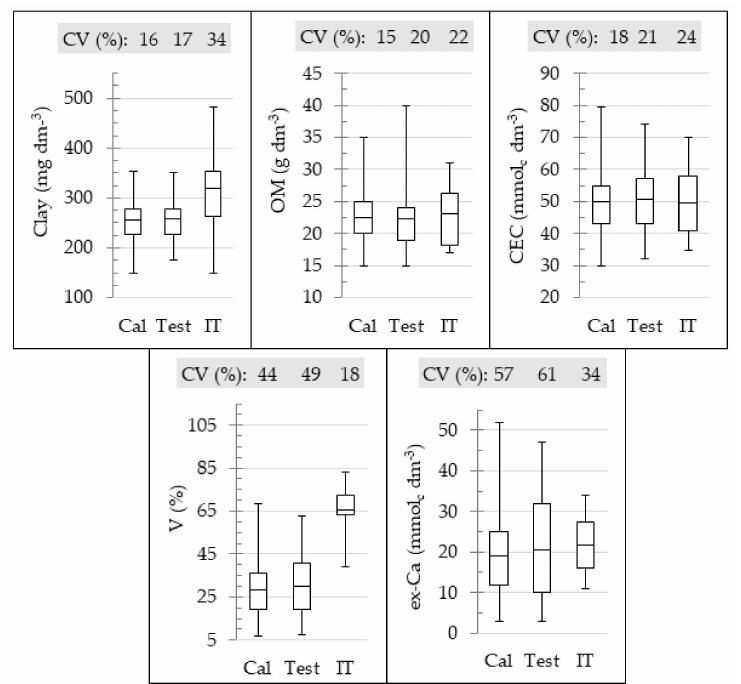
Figure A1. Box plots presenting the variation for the contents of clay, organic matter (OM), cation exchange capacity (CEC), base saturation (V), and extractable (ex-) Ca for the calibration (Cal), test, and independent test (IT) datasets. The coefficient of variation (CV) is also presented above each box